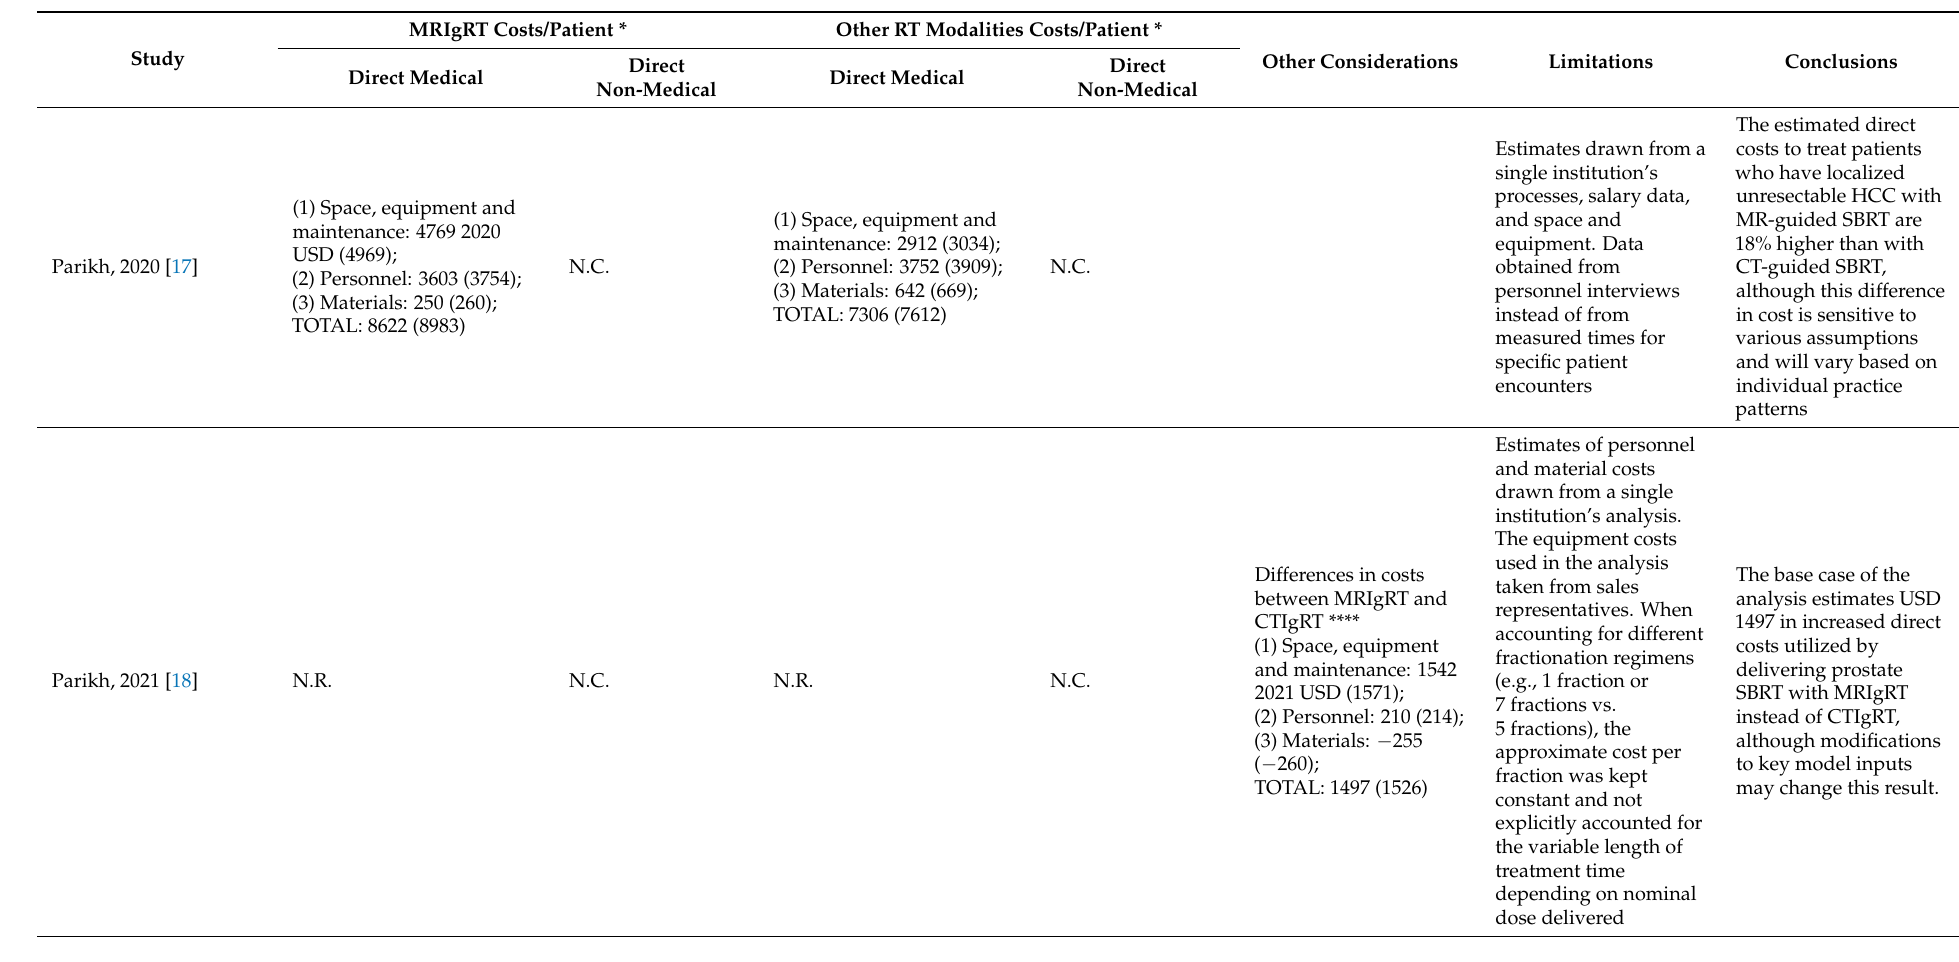
Table 3. Results of economic